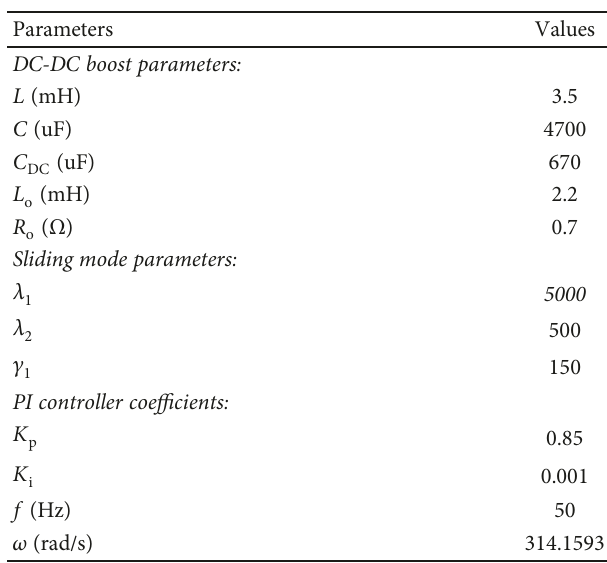
Table 2: PV system parameters used in the